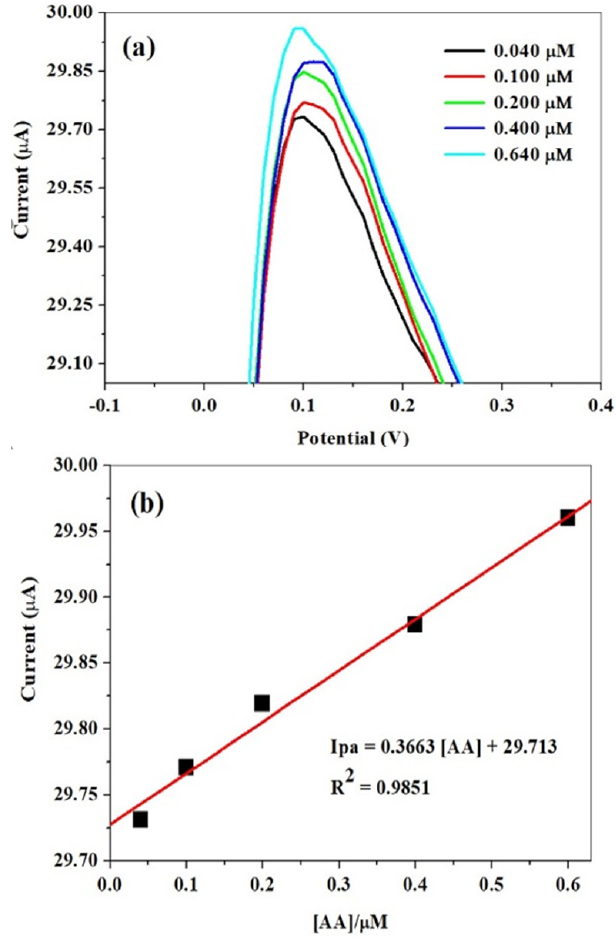
Figure 2. ( a ) AA detection within the 0.16–0.640 µM linear range, and ( b ) corresponding linear plots.